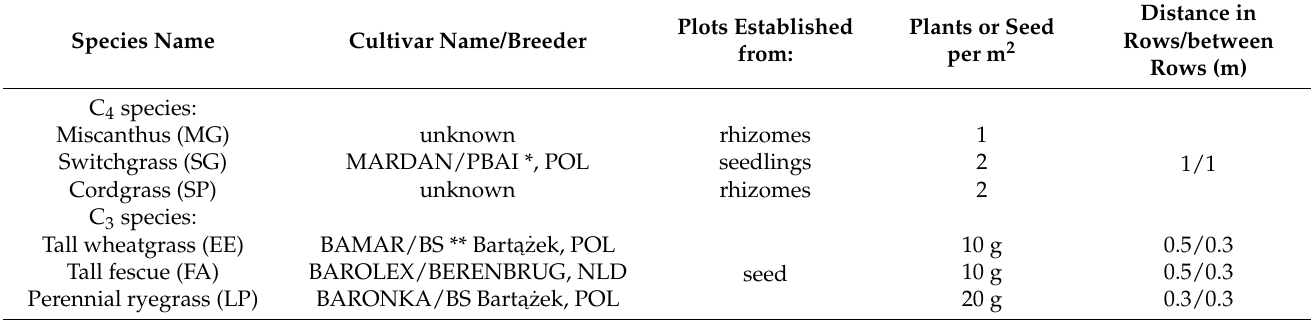
Table 1. Details of the establishment of field plots with perennial grasses for biomass